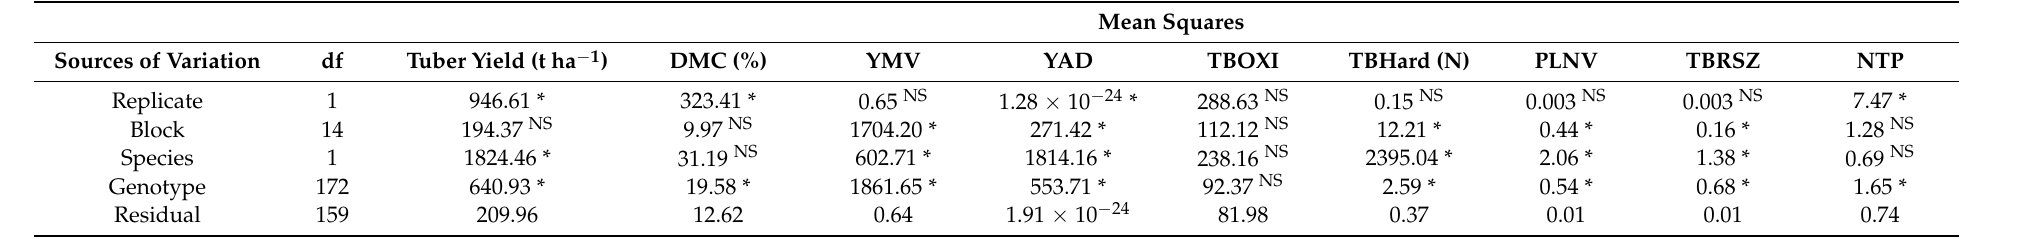
Table 1. Variation due to random effects of agronomic and tuber quality traits in D. praehensilis and D. rotundata genotypes.